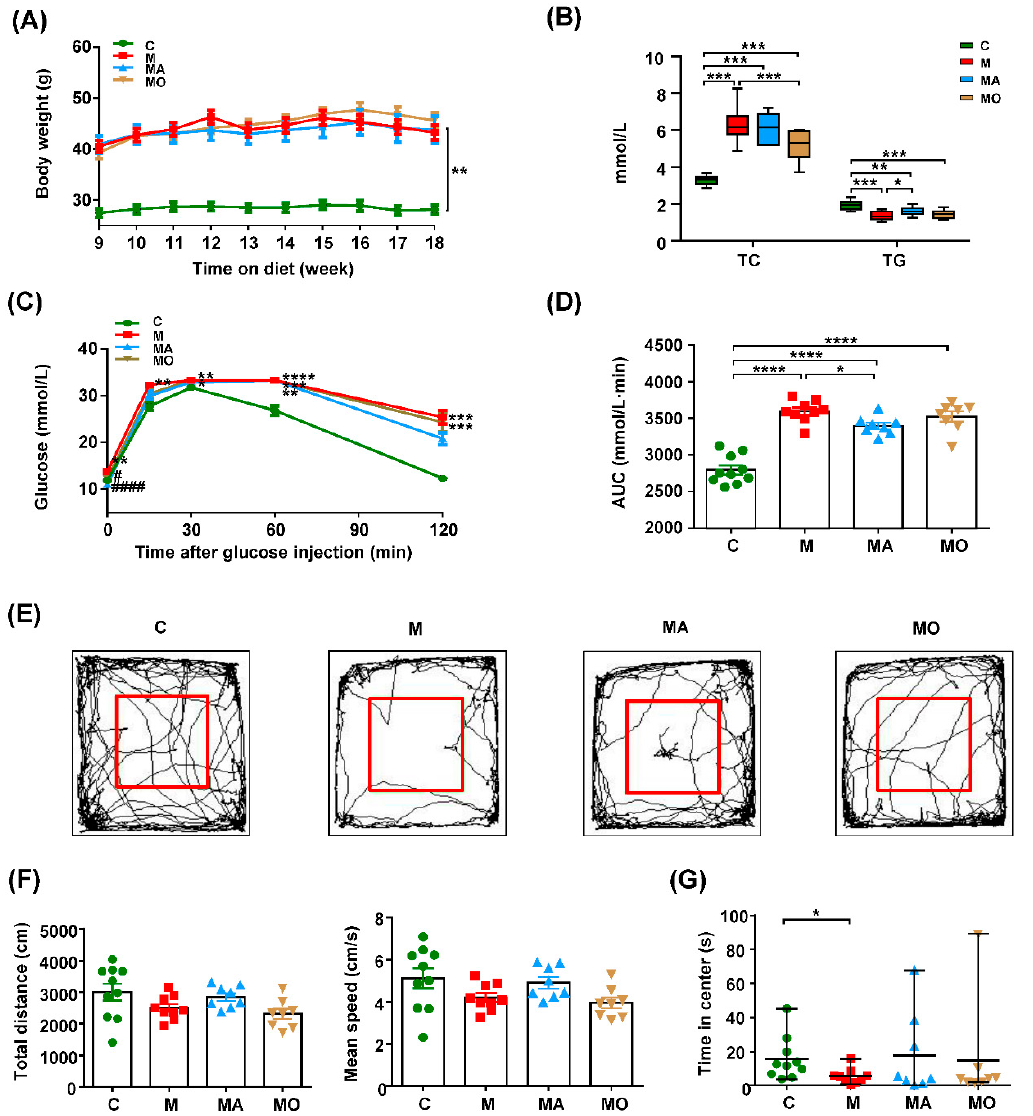
Figure 1. Obeticholic acid (OCA) supplementation inhibited the anxiety of high-fat, high-sugar (HFHS) diet-induced metabolic disorders (MDs) mice in association with gut microbiota. HFHS diet-induced MDs mice showed anxiety-like behavior, which was inhibited by OCA or eradicating-antibiotics (ABX) supplementation. ( A – D ) The body weight, serum total cholesterol (TC) and triglyceride (TG), glucose tolerance tests (GTT) and the corresponding area under the curve (AUC) were evaluated at the 18th week. ( E ) The representative trace graphs of the OF test at the 18th week. The parameters of the OF test reflecting ( F ) locomotor activity and ( G ) anxiety-like behavior are depicted. Note: data are given as mean ± SEM or medians with range. n : ( A – G ) 8–12 per group. ( A , C ) * p < 0.05; ** p < 0.01; *** p < 0.001 and **** p < 0.0001 compared with normal chow mice, # p < 0.05; #### p < 0.0001 compared with HFHS diet mice with vehicle. ( B , D , G ) * p < 0.05; ** p < 0.01; *** p < 0.001; **** p < 0.0001. Groups: C, mice with normal chow; M, mice with HFHS diet; MA, ABX-treated HFHS diet mice; MO, OCA-treated HFHS diet mice. Abbreviations: HFHS, high-fat high-sugar; MDs, metabolic disorders; ABX, antibiotics; OCA, obeticholic acid; TC, total cholesterol; TG, triglyceride; GTT, glucose tolerance test; AUC, area under the curve; SEM, standard error of mean; OF, open field.